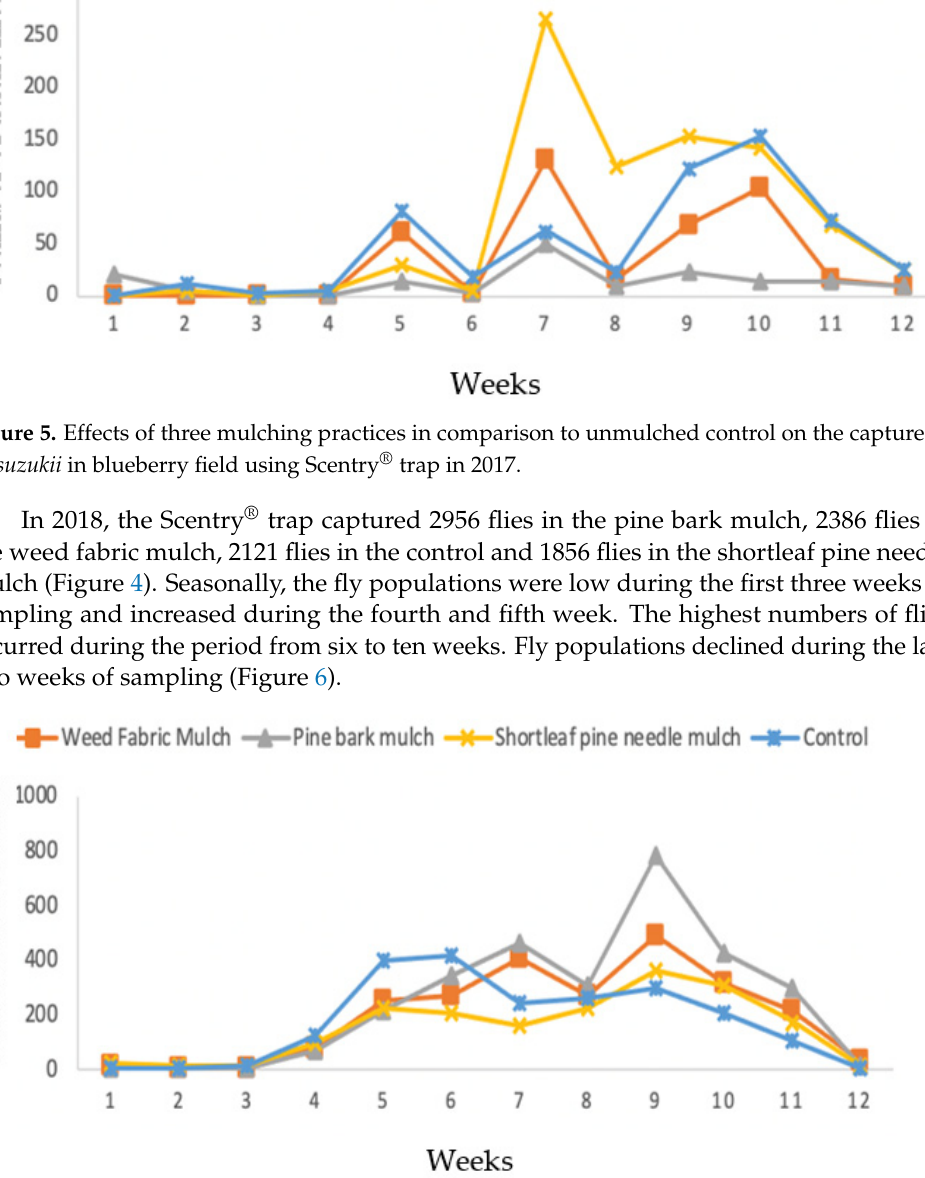
Figure 6. Effects of three mulching practices in comparison to unmulched control on the capture of D. suzukii in the blueberry field using Scentry ® trap in